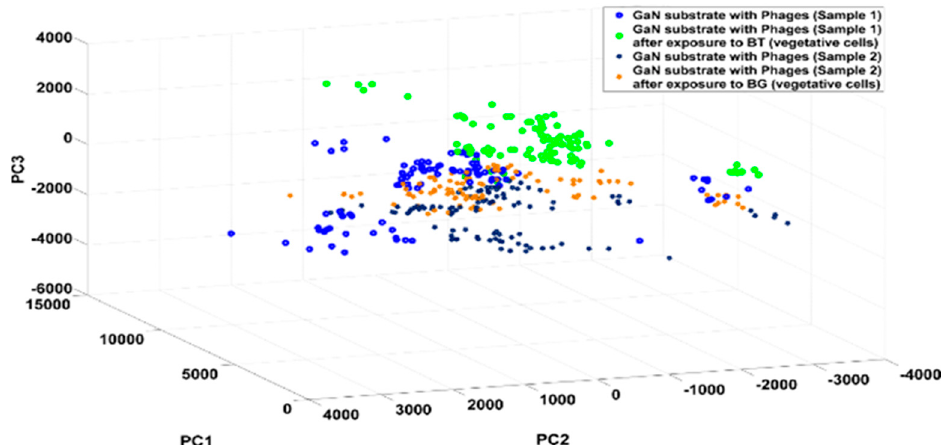
Figure 2. Principal Components (PC) score plot of the SERS spectra acquired on the clean functionalized GaN substrate (black and blue dots) and the same functionalized GaN substrate inoculated with Bacillus thuringiensis (BT, green dots) and Bacillus atrophaeus (BG, brown dots)